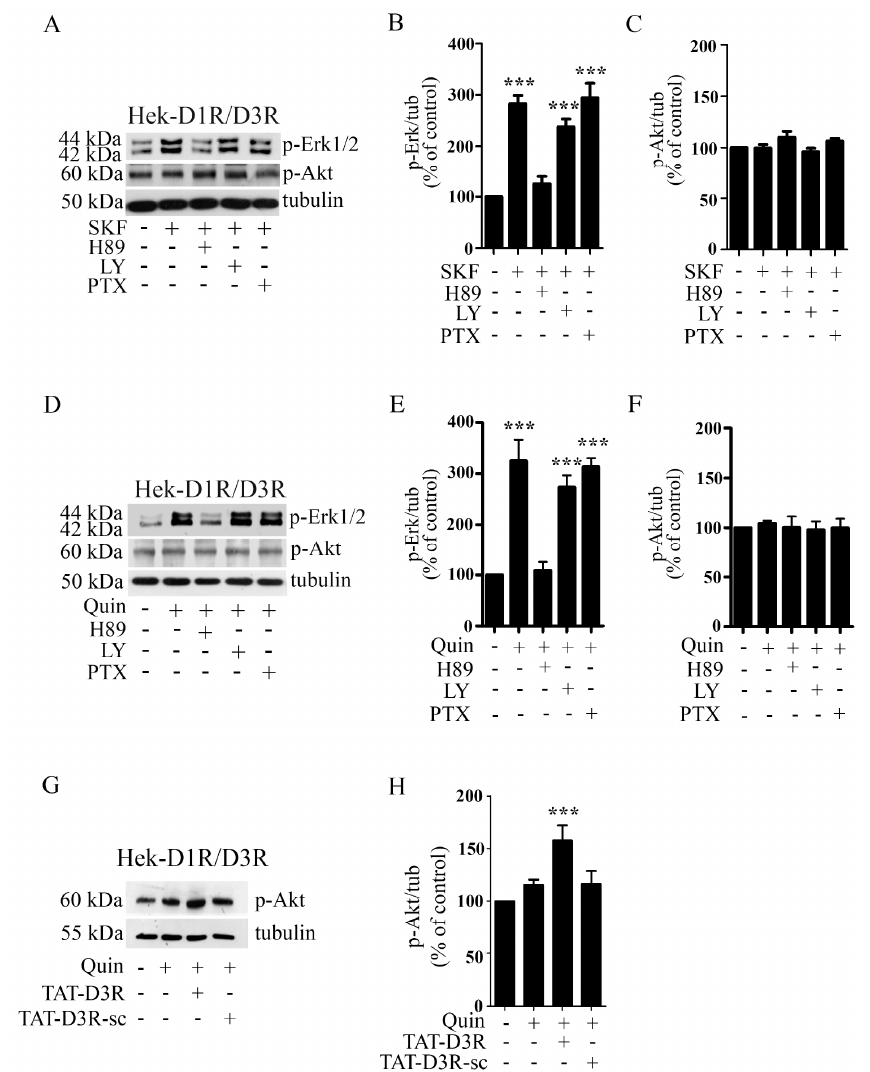
Figure 3. In Hek-D1R/D3R cells, D1R and D3R individual stimulation promotes the activation of the PKA-Erk1/2 pathway. ( A ) Hek-D1R/D3R cells were exposed to SKF (1 µ M; 5 min) in the presence or in the absence of H89 (1 µ M) or LY294002 (LY, 10 µ M) added 30 min before SKF challenging; PTX (100 ng/mL) was administered overnight before SKF treatment. Cells were analyzed for p-Erk1/2 and p-Akt activation using WB; a representative WB is shown; ( B , C ) densitometric analysis of blots with specific p-Erk1/2 (panel B ) and p-Akt (panel C ) levels normalized to the corresponding tubulin levels. Bars represent the mean ± S.E.M. *** p < 0 . 001, vs. untreated cells; (n = 4). ( D ) Hek D1R/D3R cells were exposed to Quin (1 µ M; 5 min) in the presence or in the absence of H89 (1 µ M) or LY (10 µ M) added 30 min before Quin challenging; PTX (100 ng/mL) was administered overnight before Quin treatment. Cells were analyzed for p-Erk1/2 and p-Akt using WB; a representative WB is shown; ( E , F ) densitometric analysis of blots) with specific p-Erk1/2 (panel B ) and p-Akt (panel C) levels normalized to the corresponding tubulin levels. Bars represent the mean ± S.E.M. *** p < 0 . 001 vs. untreated cells (n = 4). ( G ) Hek D1R/D3R cells were exposed to Quin (1 μ M; 5 min) in the presence or in the absence of TAT-D3R (1 μ M) or TAT-D3R-sc (1 μ M) and analyzed for p-Akt using WB; a representative WB is shown; ( H ) densitometric analysis of blots (n = 4) with specific p-Akt levels normalized to the corresponding tubulin levels. Bars represent the mean ± S.E.M. *** p < 0 . 001 vs. untreated cells. Data were statistically analyzed using one-way ANOVA followed by post hoc comparison with the Bonferroni